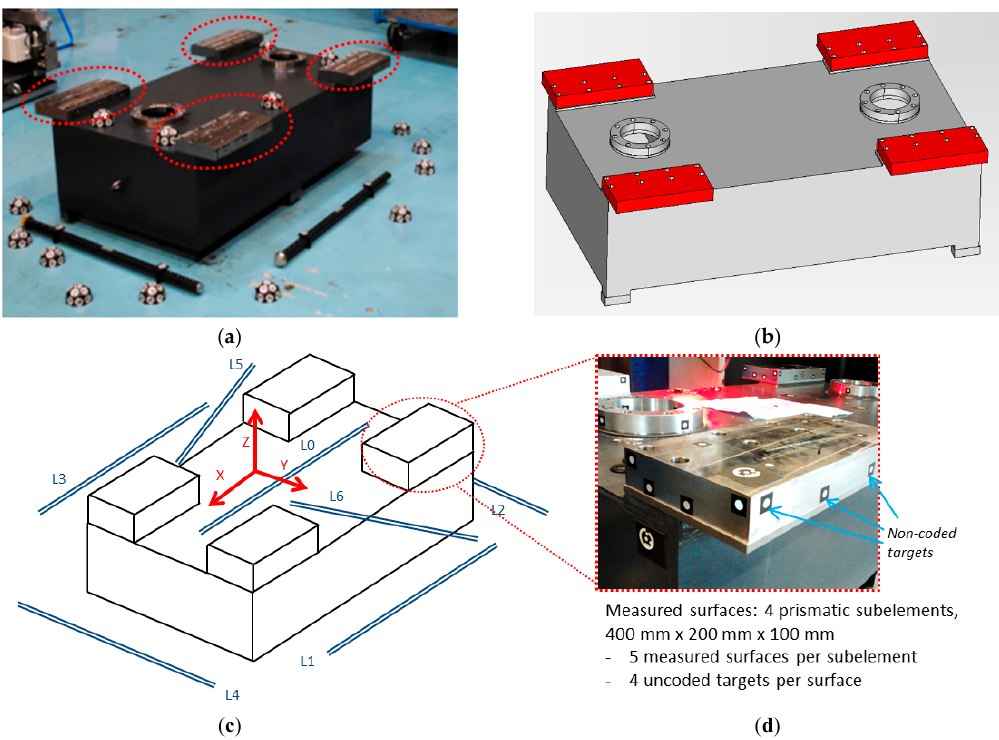
Figure 3. Steel raw part pilot case ( a ) under analysis (1.5 m × 1 m × 0.5 m) with prismatic subelements (in red, 400 mm × 200 mm × 100 mm) milled to a 0.01 mm precision, with multicoded targets around the scene for assisting image matching; ( b ) CAD describing nominal reference surfaces (in red), and ( c ) uncertainty evaluation scene and scale bar lay-out for LME evaluation, with non-coded targets on surfaces to measure ( d ).